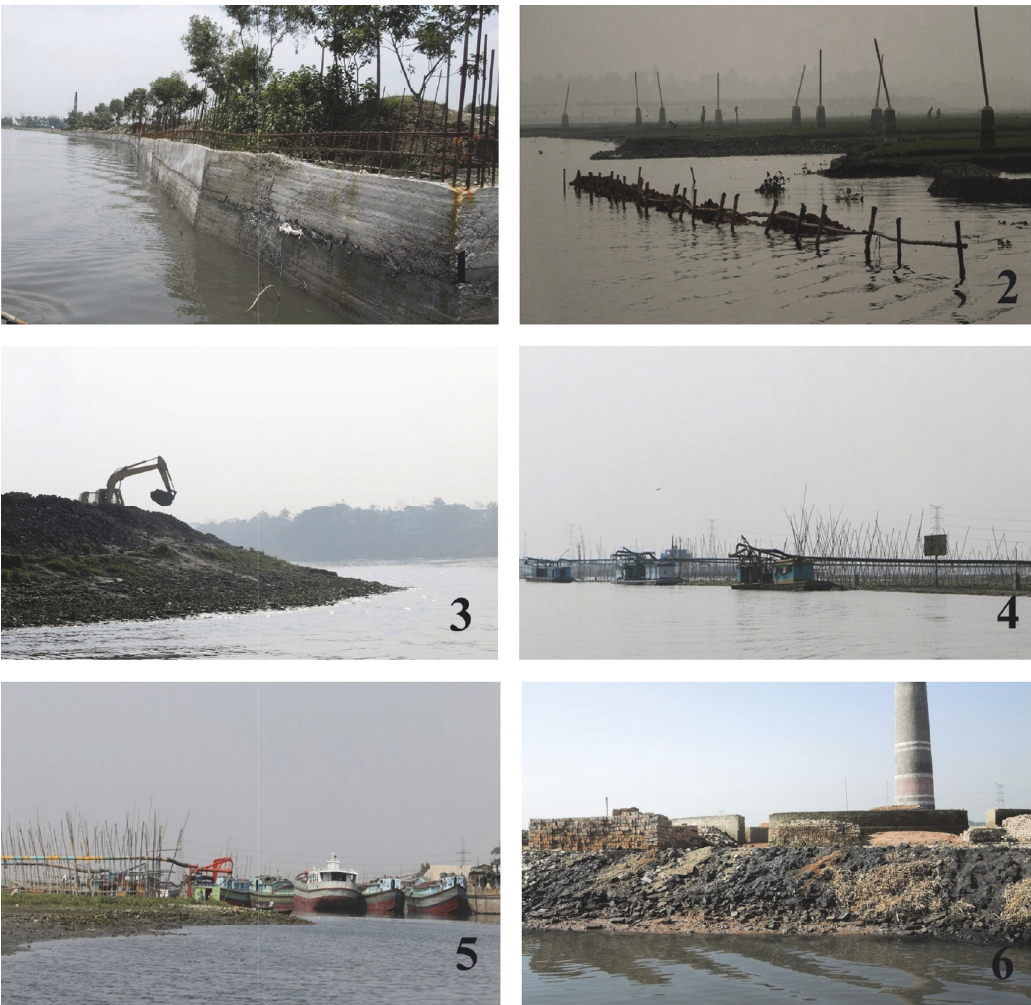
Figure 5: Environmental threats of Turag River. (1, 2, and 3) Encroachment of river by filling up river beds. (4) River fill-up by sand using unload dredgers. (5) River blocked by water vessels. (6) Brick field along the